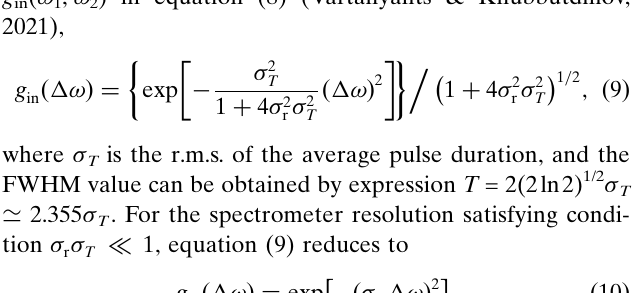
Figure 4 ( a , c , e ) Spectral second-order correlation function analysis at the 180 pC bunch charge. ( b , d , f ) Correlation functions g (2) ( (cid:2) ! ) (black lines) shown along the white dashed lines in ( a , c , e ). Blue dashed lines show the fit of the central peak in ( a , c , e ). ( a , b ) SASE radiation, ( c , d ) monochromatic radiation, ( e , f ) self-seeding regime of operation. ( b , d , f ) One-dimen- sional profiles along the white dashed lines in ( a , c , e ) shown by black lines. All results presented in this figure correspond to the 180 pC bunch